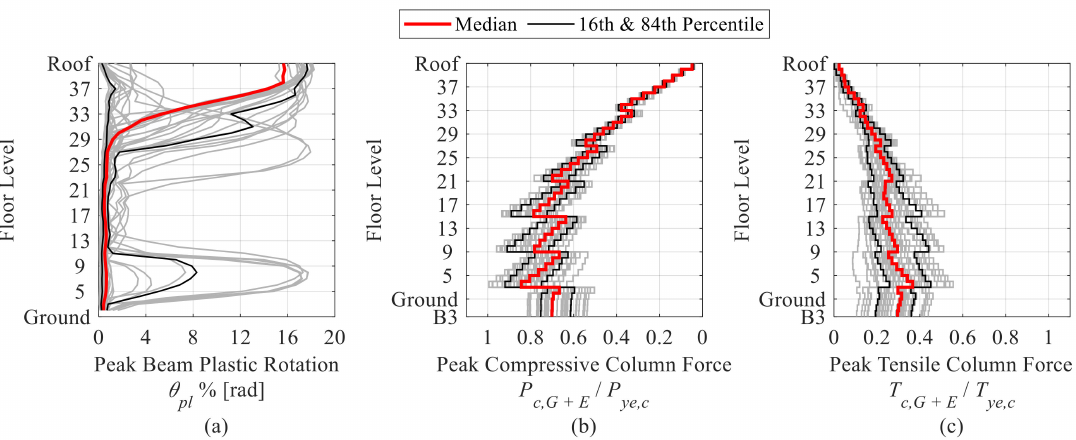
Figure 6. ( a ) Peak beam plastic rotations, ( b ) normalized peak compressive, and ( c ) tensile column forces (BSE-2E).